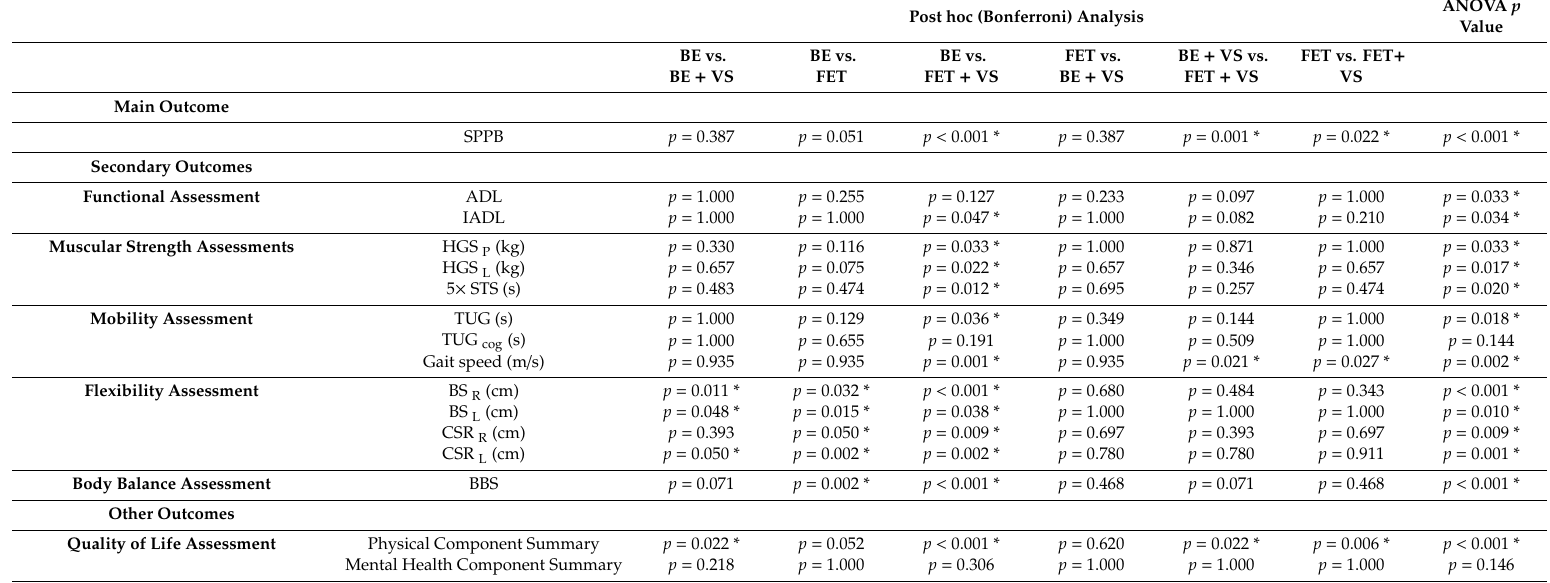
Table 3. Between-group comparisons at 12